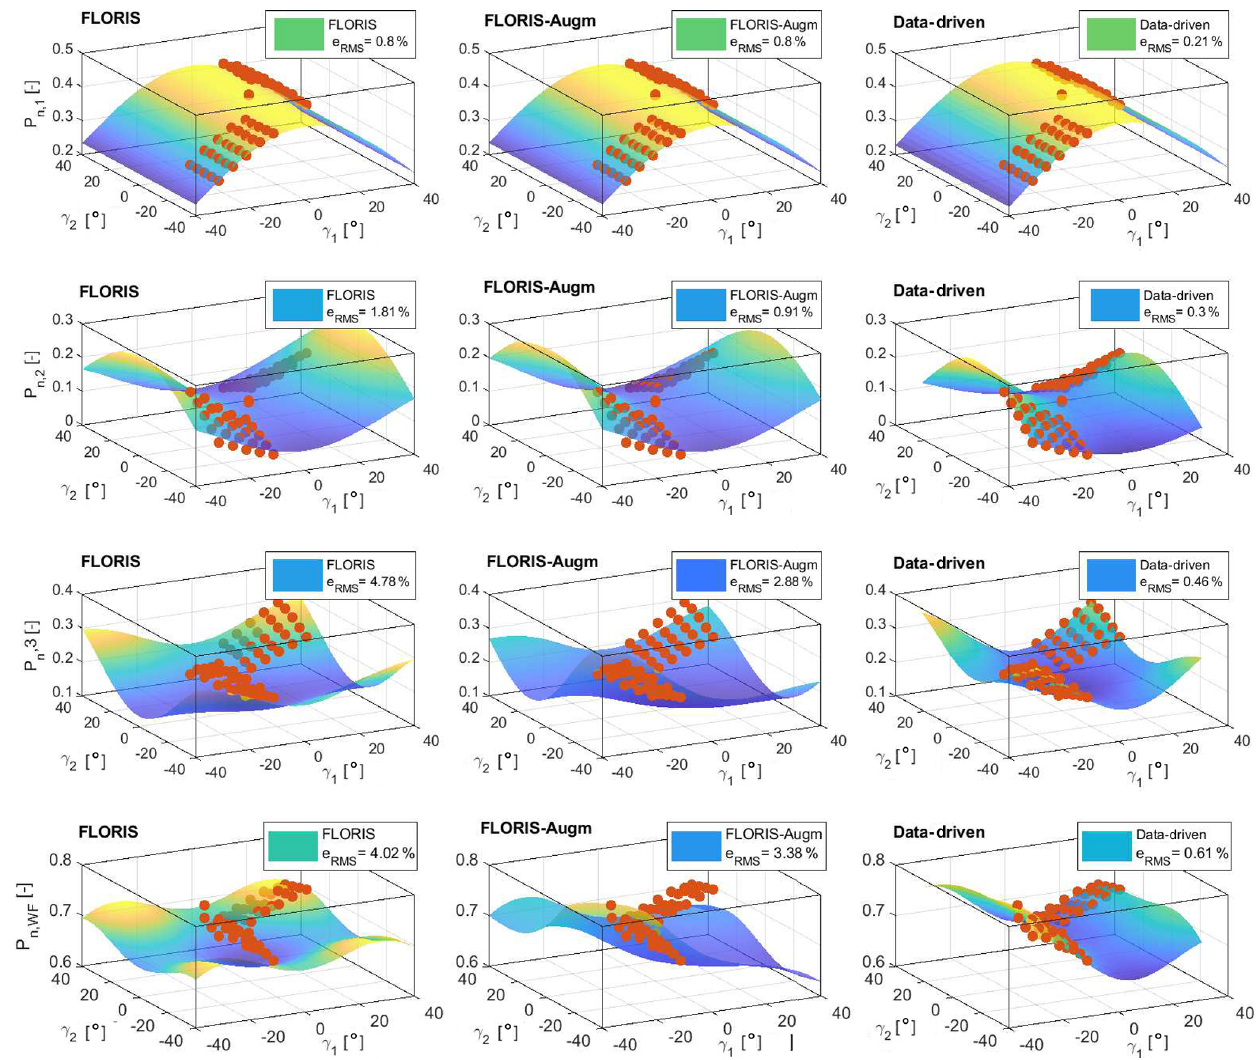
Figure 7. Normalized power of WT1 (first row), WT2 (second row), WT3 (third row), and the wind farm (fourth row), as functions of the misalignment angle γ of the two front turbines WT1 and WT2, for the wind direction (cid:56) = 0 ◦ . Red dots: experimental measurements. Smooth surfaces: baseline FLORIS (left), FLORIS-Augm (center), and data-driven (right) models.